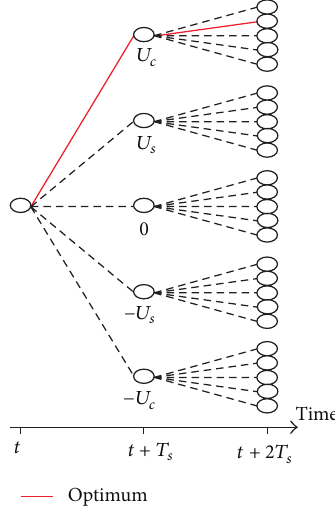
Figure 10: Three of the combinations in two-step prediction.